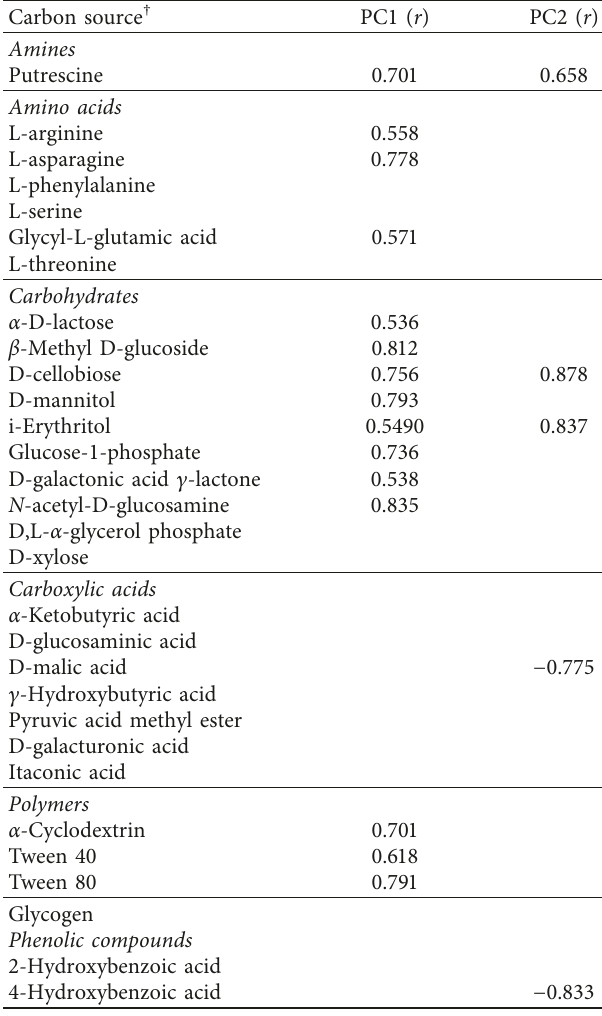
Table 3: Correlation coefficients of the first two principal com- ponents (PC1and PC2) from the water samples collected at three different